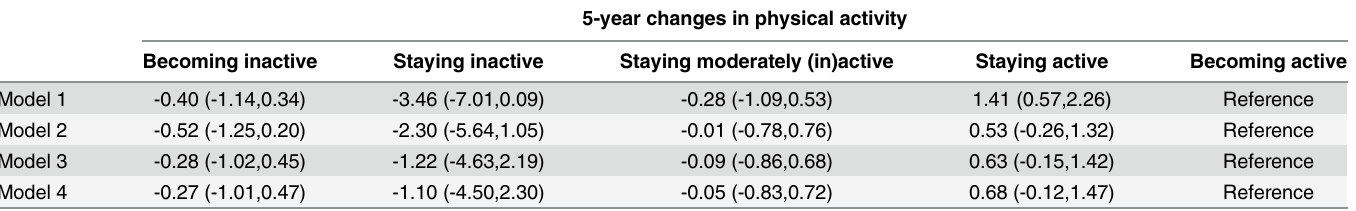
Table 3. Regression coefficients (mL/min per 1.73 m 2 ) and 95% confidence intervals for the associations between 5-year changes in physical activity and cystatin C-based estimated glomerular filtration rate at the subsequent round, adjusted for attained time-varying